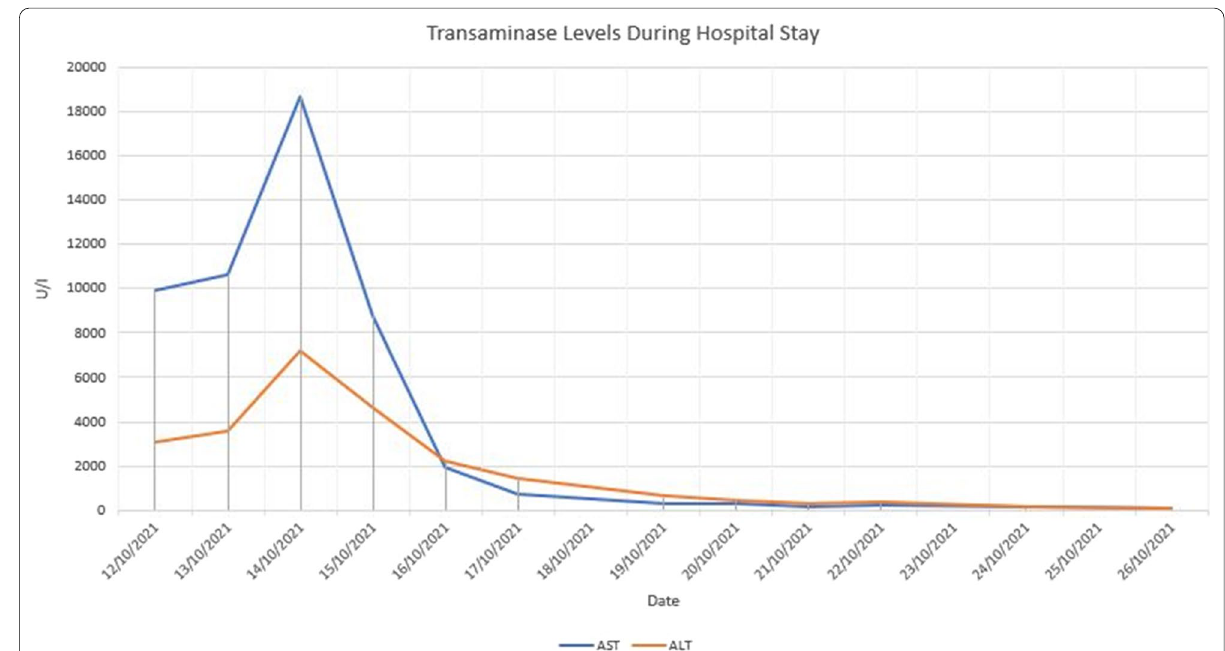
Fig. 5 Progression of liver enzymes during the ICU stay. The transaminase levels dropped progressively, but the bilirubin levels were rising.